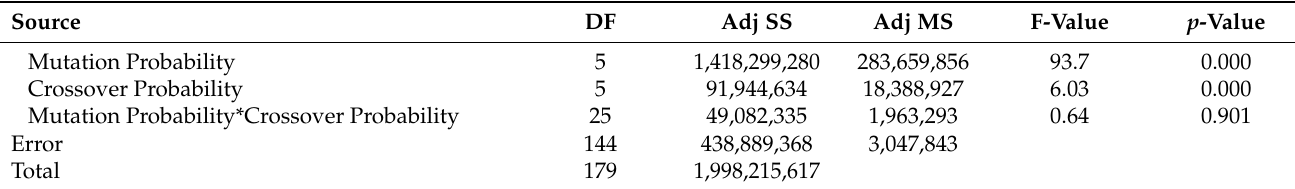
Table 16. Output of the analysis of variance for Problem-4.